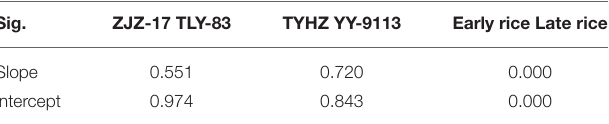
TABLE 3 | Validation NNI int and RY models at different stages for early and late rice. Sig. ZJZ-17 TLY-83 TYHZ